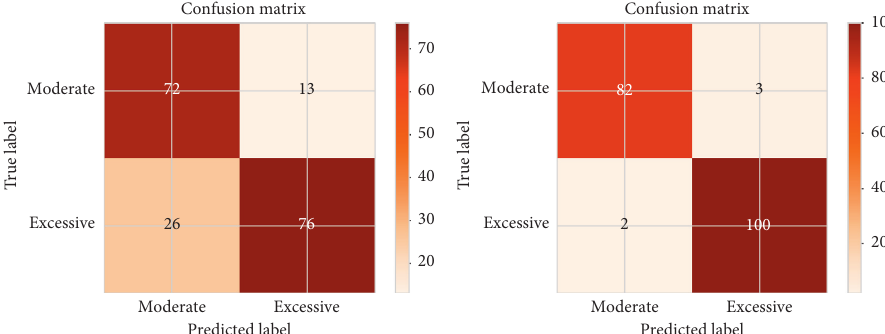
Figure 7: Confusion Matrix of the test dataset computed by (a) Shallow Neural Network and (b) Deep Neural Network.